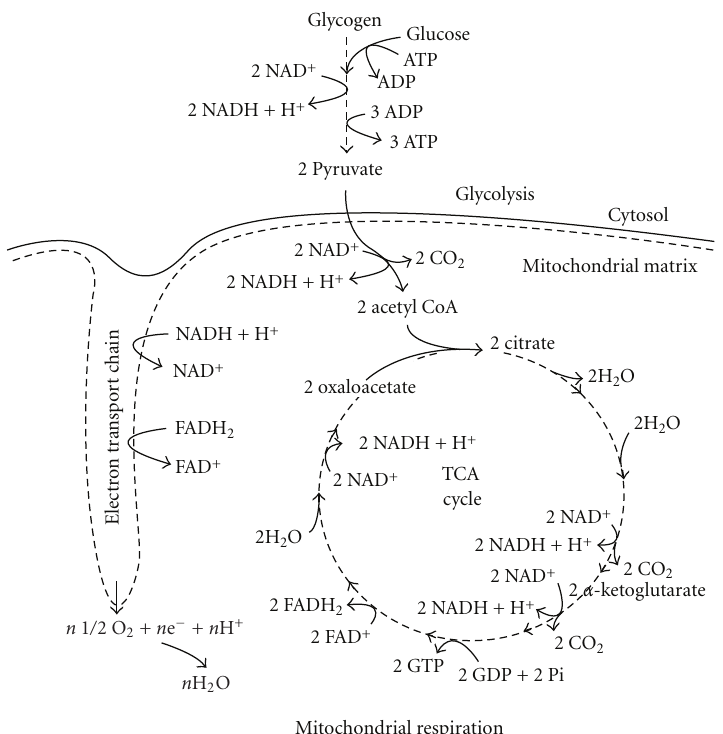
Figure 12: The biochemical connections between the cytosol and mitochondria of skeletal muscle for the complete oxidation of carbohydrate. Note that the TCA cycle as shown is not complete for all substrates and products. Also, the ATP yield from carbohydrate oxidation is greater for the substrate glycogen than glucose. For skeletal muscle, there are 37 molecules of ATP produced from one Glucose- 6-phosphate derived from glycogen, assuming the presence of the glycerol-3-phosphate